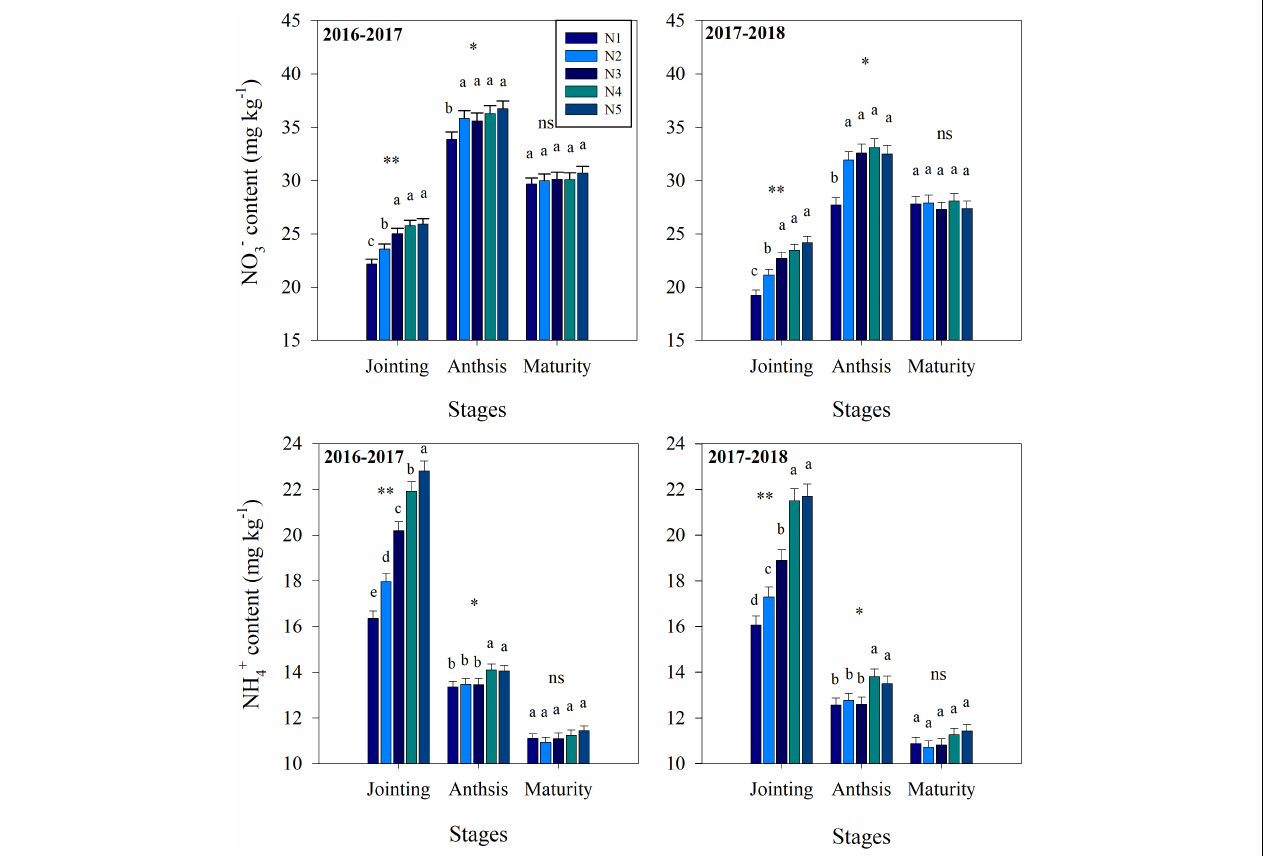
FIGURE 3 | The effects of split nitrogen fertilizer on NO 3 − content and NH 4 + content. Different letters indicate significant differences between treatments ( P < 0.05). ∗ , ∗∗ significant at the 0.05 and 0.01 probability levels, respectively, ns, no significant. N1 (basal/dressing, 100/0%), N2 (basal/dressing, 70/30%), N3 (basal/dressing, 50/50%), N4 (basal/dressing, 30/70%), and N5 (basal/dressing,